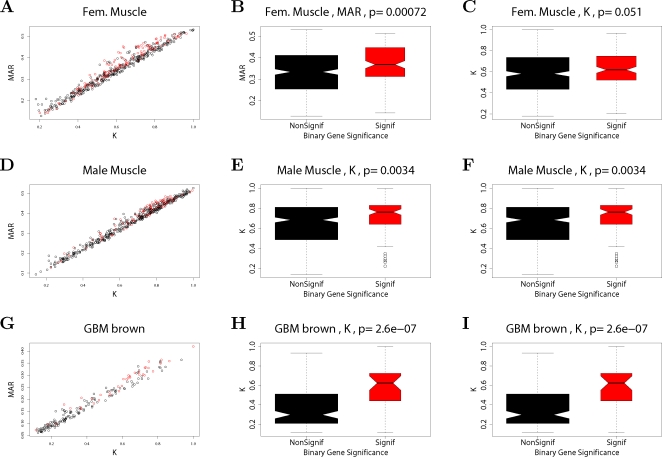
Relationships among maximum adjacency ratio, scaled connectivity, and gene significance.(A) The relationship between MARi (y-axis) and scaled connectivity Ki using the female mouse muscle tissue network described in the motivational example. The genes are colored red or black depending on whether they are significantly (p-value<0.05) related to mouse body weight. (B) Boxplots and a Kruskal-Wallis test p-value (p = 0.00072) for studying whether MARi differs between significant (red) and non-significant (black) genes. (C) The analogous boxplots and p-value for the scaled connectivity Ki. In this female muscle tissue application, MARi is more significantly (p = 0.00072) related to GSi than is Ki (p = 0.051). (D,E,F) The analogous relationships for male muscle. Here, the MARi is more significantly (p = 0.00014) related to GSi than is Ki (p = 0.0034). (G,H,I) The analogous relationships for the brown module of the brain cancer application. Here, the MARi is slightly more significantly (p = 1.6E-8) related to GSi than is Ki (p = 2.6E-7). As a caveat, we mention that in other applications (e.g., the yeast network), we have found that Ki is more significantly related to GSi than MARi.